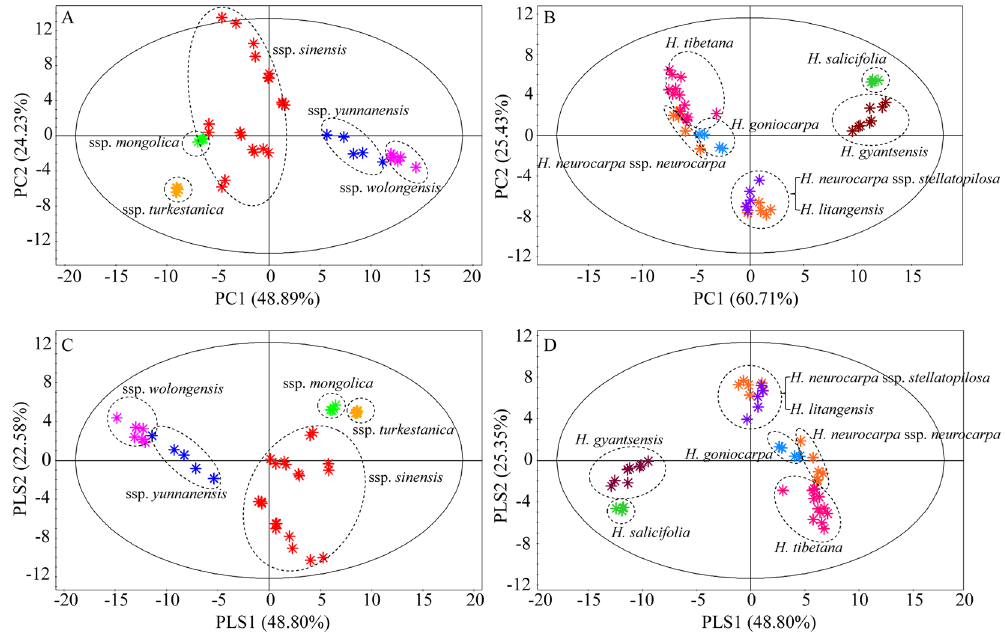
Figure 2. Multivariate model plots of the 1 H NMR data. ( A ) PCA score plot of five H . rhamnoides subspecies, ( B ) PCA score plot of the remaining six Hippophaë species, ( C ) PLS-DA score plot of five H . rhamnoides subspecies, ( D ) PLS-DA score plot of the remaining six Hippophaë species.